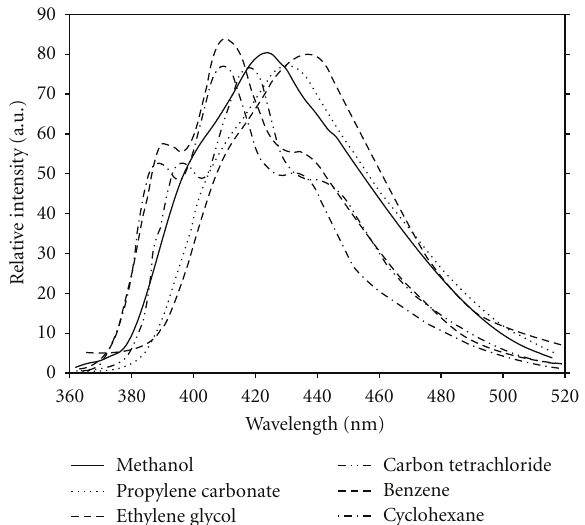
Figure 2: Emission spectra of 1 × 10 − 5 moldm − 3 (POPOP) in di ff erent solvents ( λ ex = 380nm).